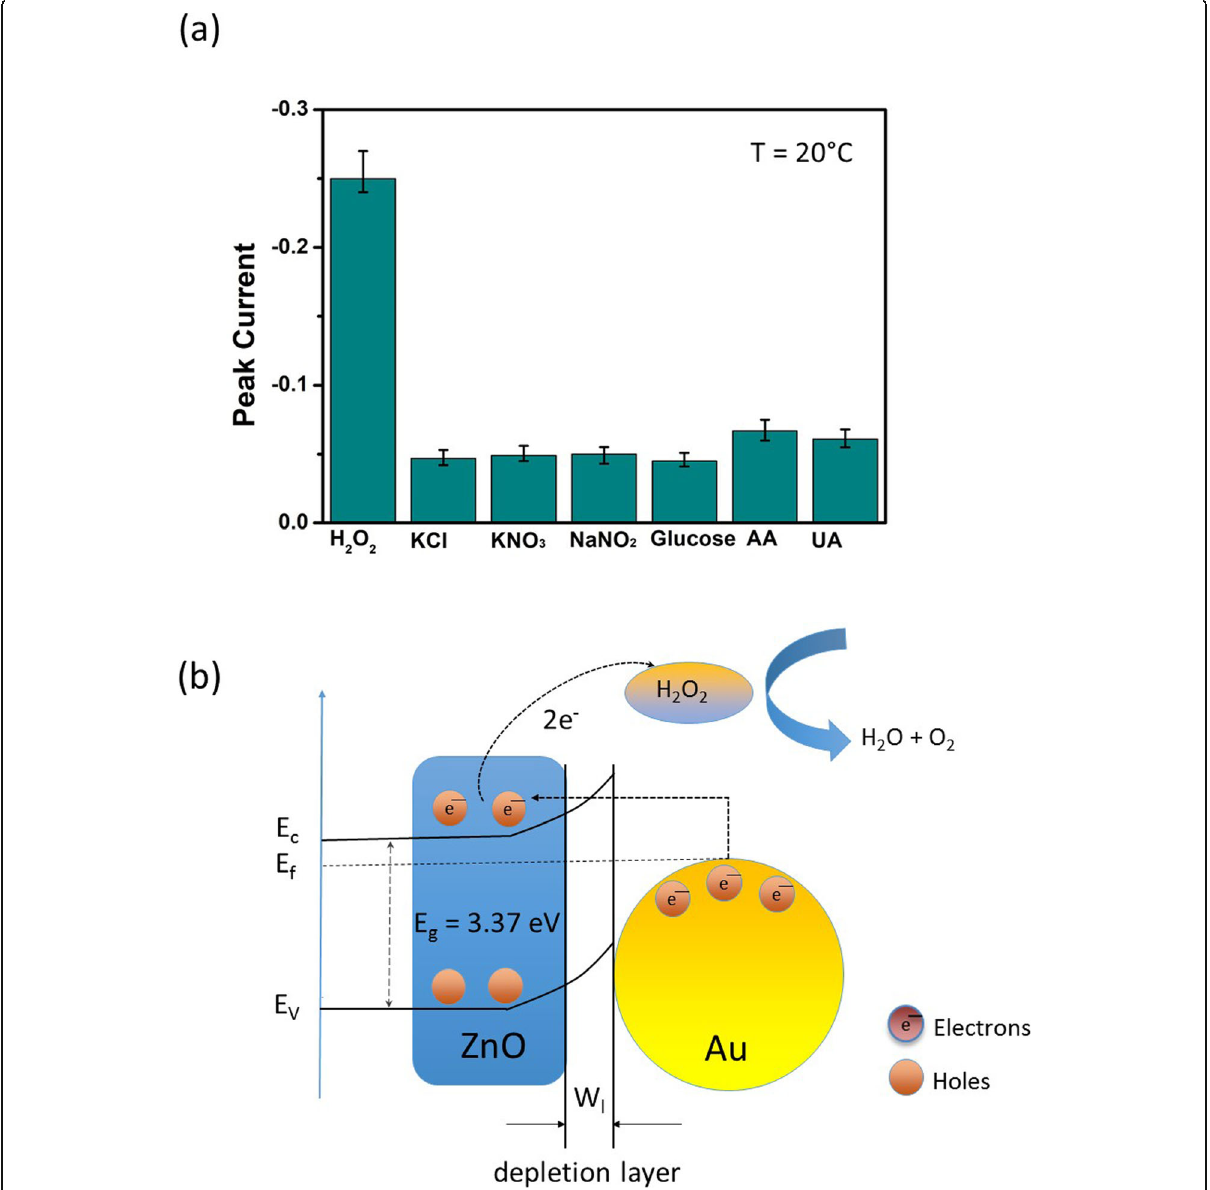
Fig. 6 a Interference study of the H 2 O 2 sensor based on Au-ZnO heterojunction at the presence of 10 μ M H 2 O 2 and 1.0 mM of different interfering chemicals at 25 °C. b Schematic band diagram of Au-ZnO heterostructure under exposure to H 2 O